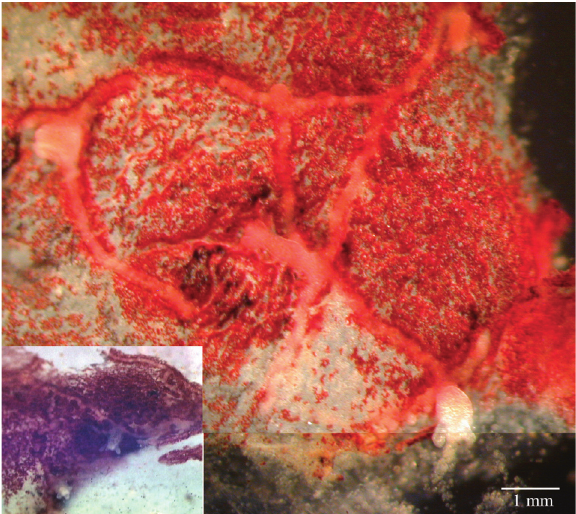
Fig . 3. – Photograph mosaic of athecate hydrozoan polyp colony on dermis of Enypniastes eximia . inset is miniDV video framegrab of separate fragment of dermis, also supporting